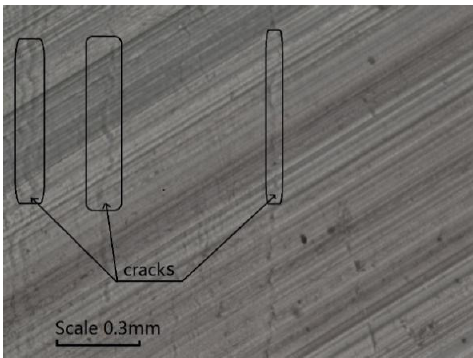
Figure 3. Optical microscopy photos of interface region in extruded molding joint (EMJ) samples with the indications of defected cracks.